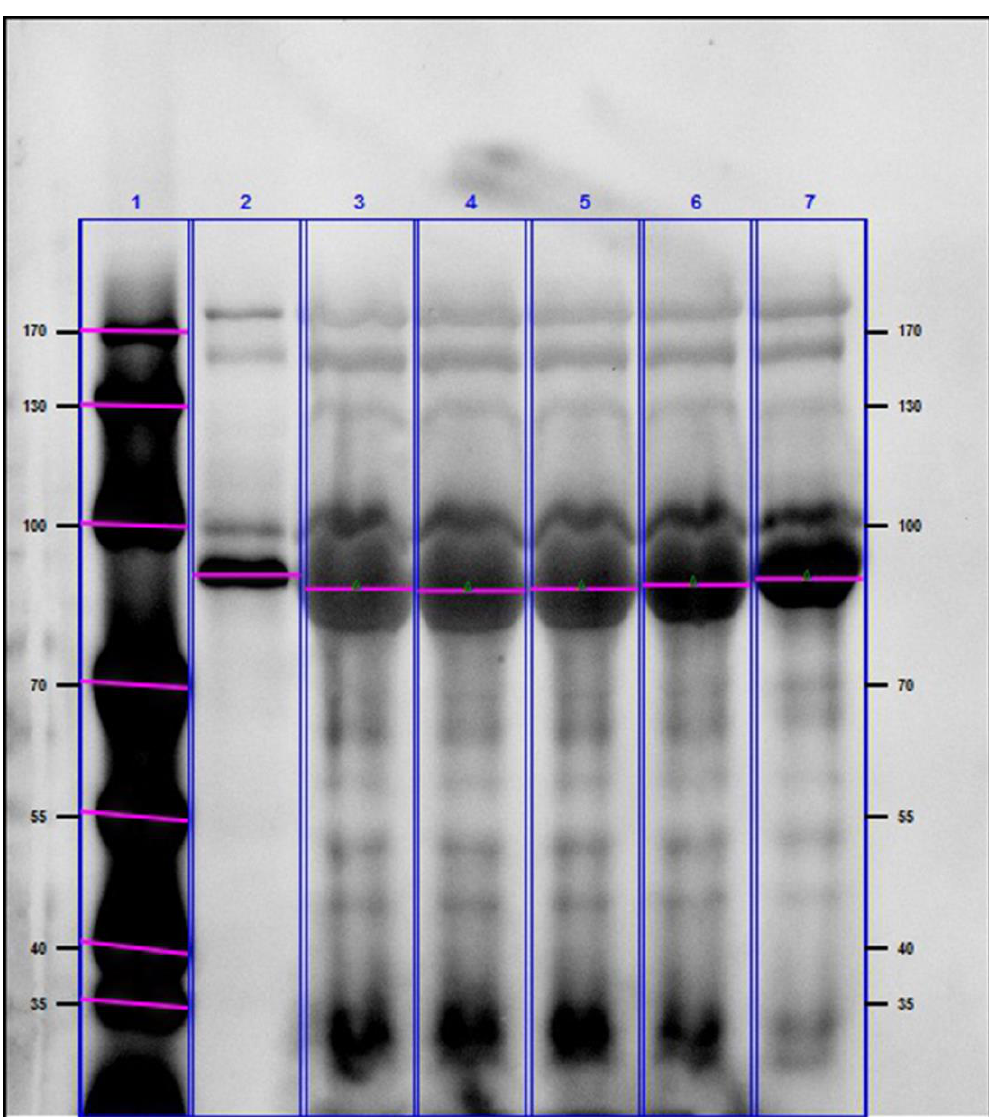
Figure 4. Gel-based fluorescence image of the semiquantitative analysis with 10 µ M of probe 1 . Samples were prepared by incubating 2.0 mg/mL proteomes at different conditions: Lane 1 — Marker; Lane 2 — Serum in a rat acute myocardial infarction model treated with probe 1 ; Lanes 3 – 7 — Serum blanks with increasing quantities of RMGPa (0, 12.5, 25, 50, and 100 ng/mL at a final concentration) treated with probe 1 .